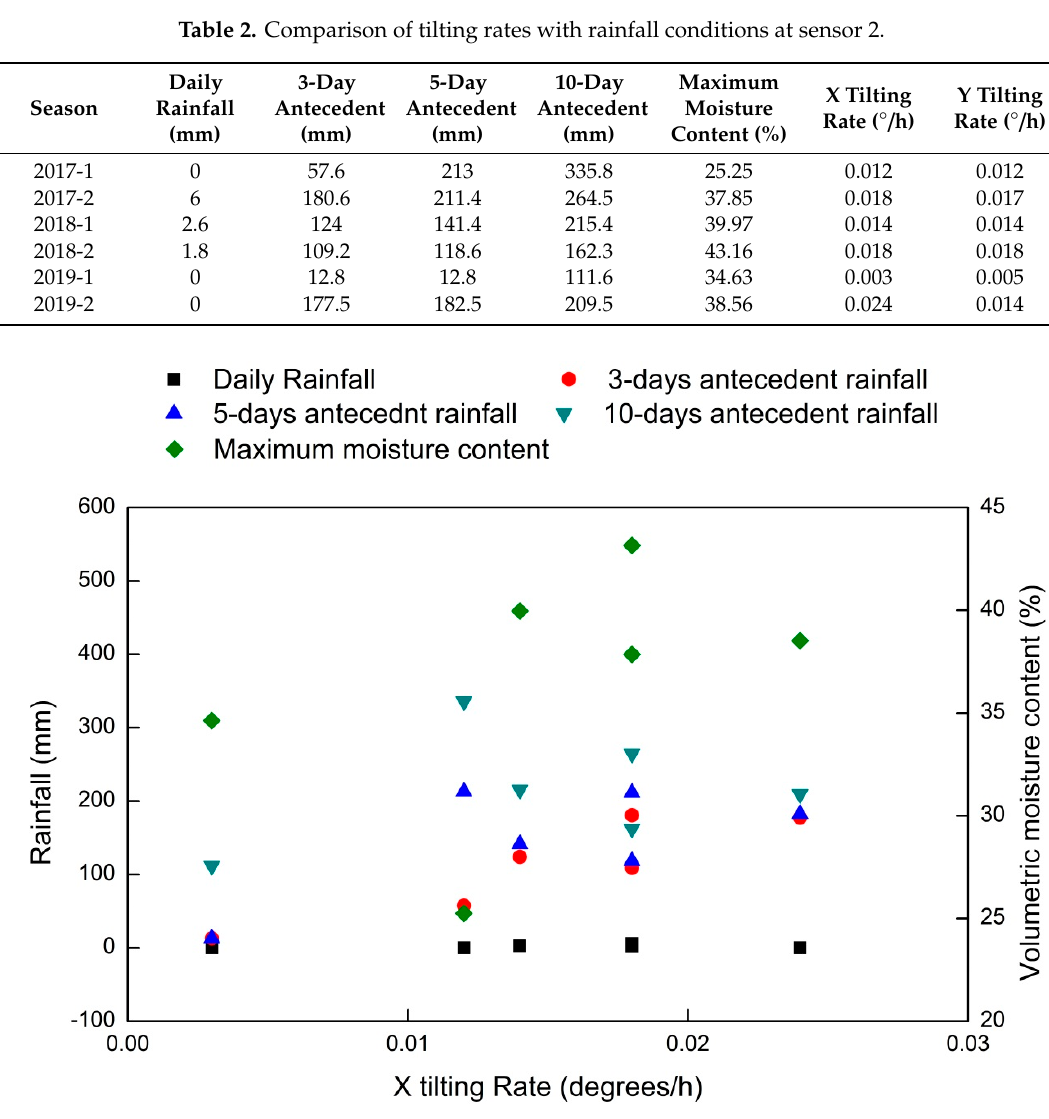
Figure 14. Tilting rate variation for sensor 2 for various displacement periods during study period with respect to rainfall and moisture conditions.